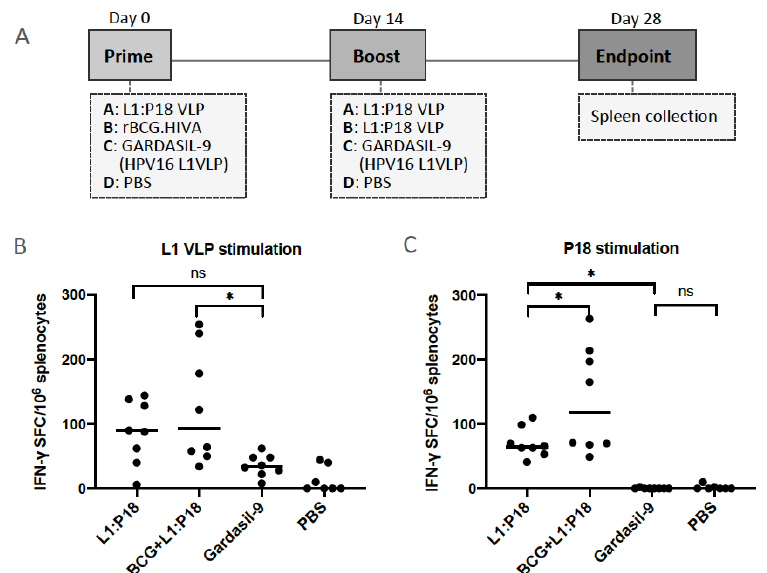
Figure 7. Induction of HPV16 and HIV-1 specific T cell responses by chimeric L1:P8I10 VLPs and rBCG.HIVA in BALB/c mice. The immunization schedule is depicted in ( A ). All mouse groups had equal gender distribution (male n = 4 and female n = 4). Group A: homologous prime-boost immunization with 10 μg L1:P18I10 VLPs intramuscularly (i.m.); Group B: priming with 106 cfu rBCG.HIVA intradermally (i.d.) and boosting with 10 μg L1:P18I10 VLPs i.m.; Group C: homolo-